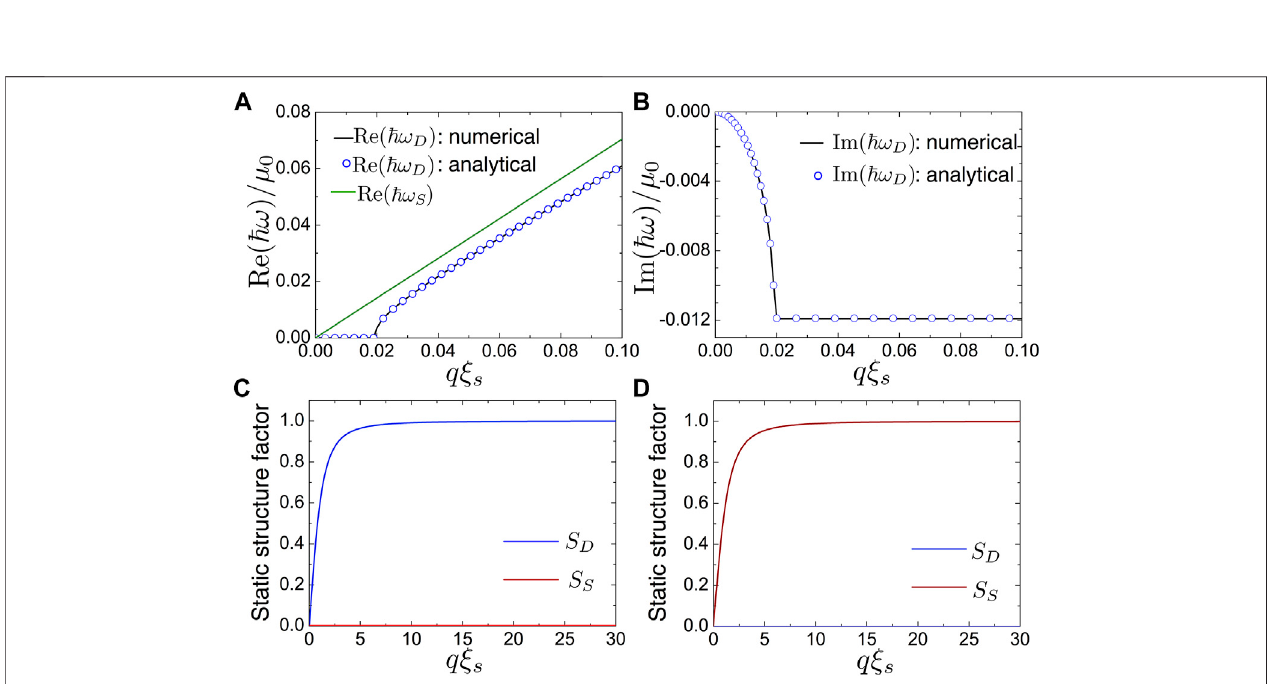
FIGURE 3 | Manifestation of dissipation-enabled decoupling of excitations in the linear regime. Panels (A) and (B) : (A) real and (B) imaginary parts of the energy of density excitation Z ω D and energy Z ω S ofspin-polarization excitation,respectively. SolidcurvesdepictnumericalsolutionsofBogoliubov ’ sequations, andthecurve with circlesindicate analytical solutions. (C,D) Density staticstructurefactor S D ( q )and spin-density static structure factor S S ( q ) whenthespinorpolaritonBEC issubjectedto a perturbation of the form (C) λ e i ( qx − ω t ) + H. c and (D) λσ z e i ( qx − ω t ) + H. c (see main text). Same parameters as in Figure 2 are used.